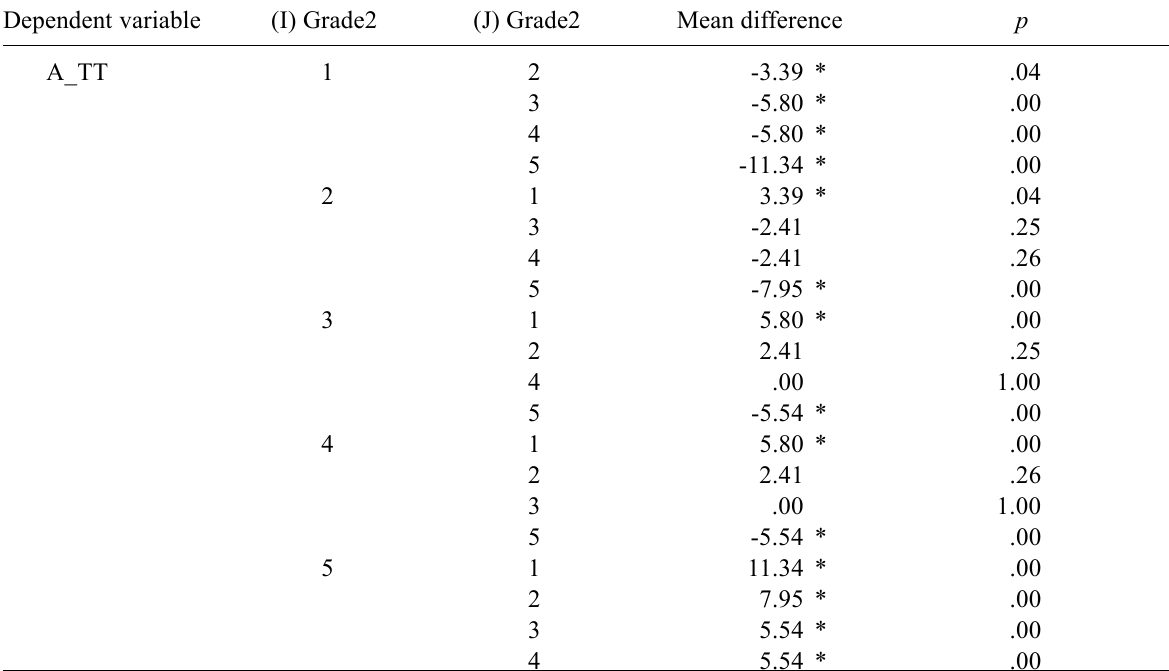
Differences in Mean Verified by Tukey Analysis between Each Evaluated Grade for the Total Score of Form A Dependent